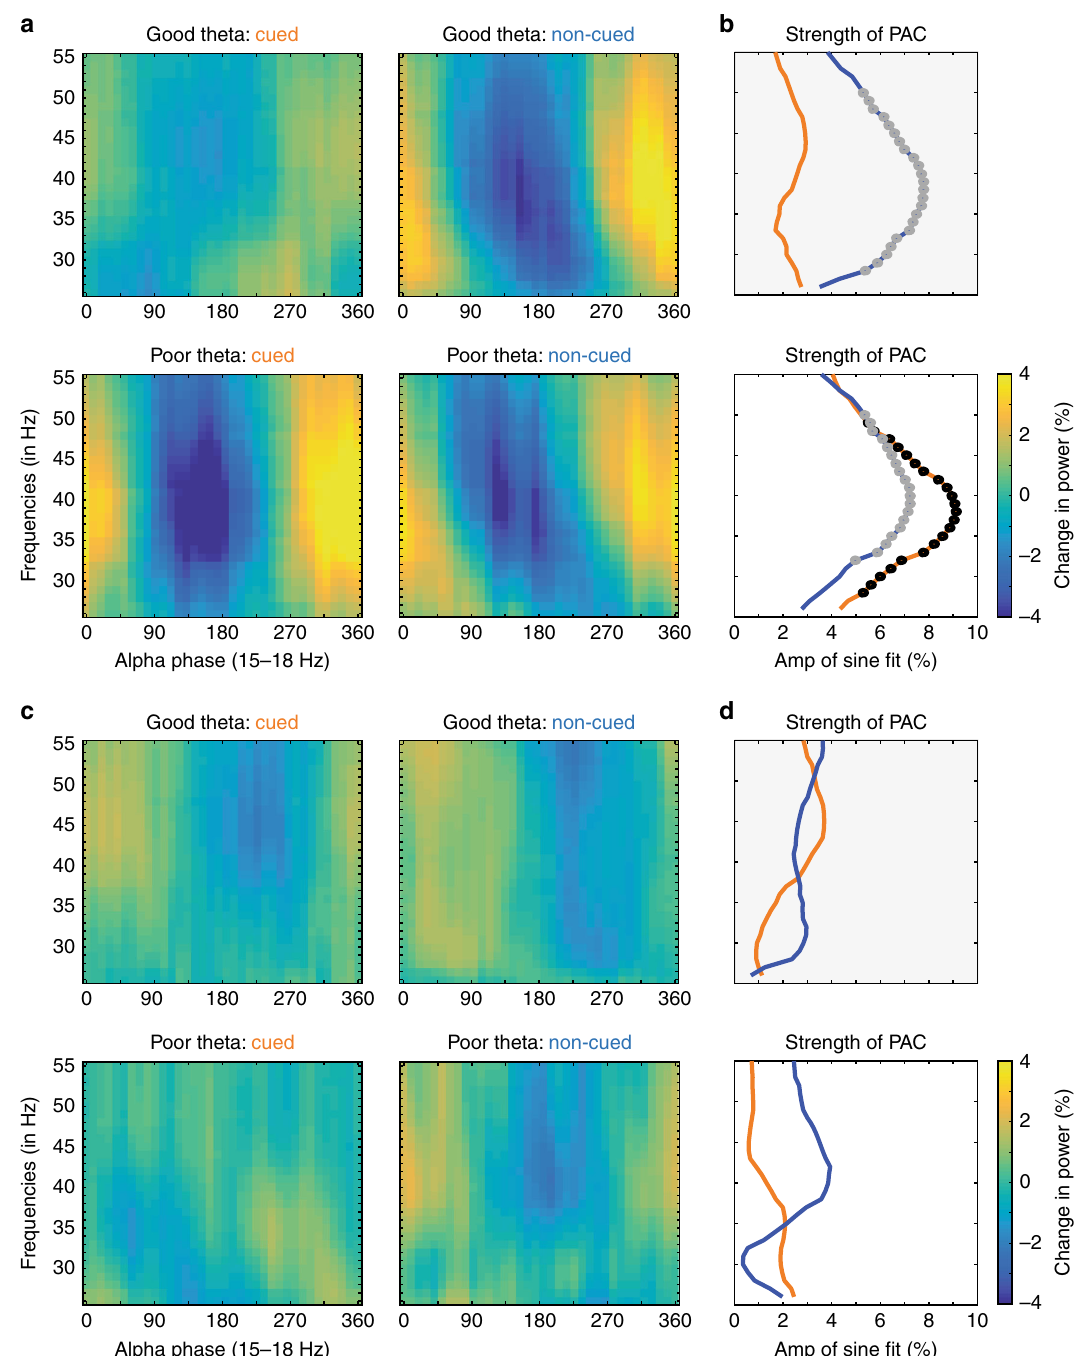
Fig. 8 PAC in LIP between alpha/low-beta phase and gamma power is state-dependent. We measured phase – amplitude coupling after fi rst binning trials based on the theta phase, with one bin centered on the “ good ” theta phase (i.e., the phase associated with better visual-target detection) and the other centered on the “ bad ” theta phase (i.e., the phase associated with worse visual-target detection). Panels a , b show power as a function of alpha/low-beta phase by theta-phase bin (good vs. poor) and by attention condition (cued [orange] vs. non-cued [blue]), for both a LIP ( N = 96) and b mdPul ( N = 95). c , d The strength of PAC was measured by using the fast Fourier transform to extract the amplitude of a one-cycle, sinusoidal component (see Fig. 2a for an illustration of this approach), for both c LIP and d mdPul. The black (cued location) and gray (uncued location) dots represent statistically signi fi cant results after corrections for multiple